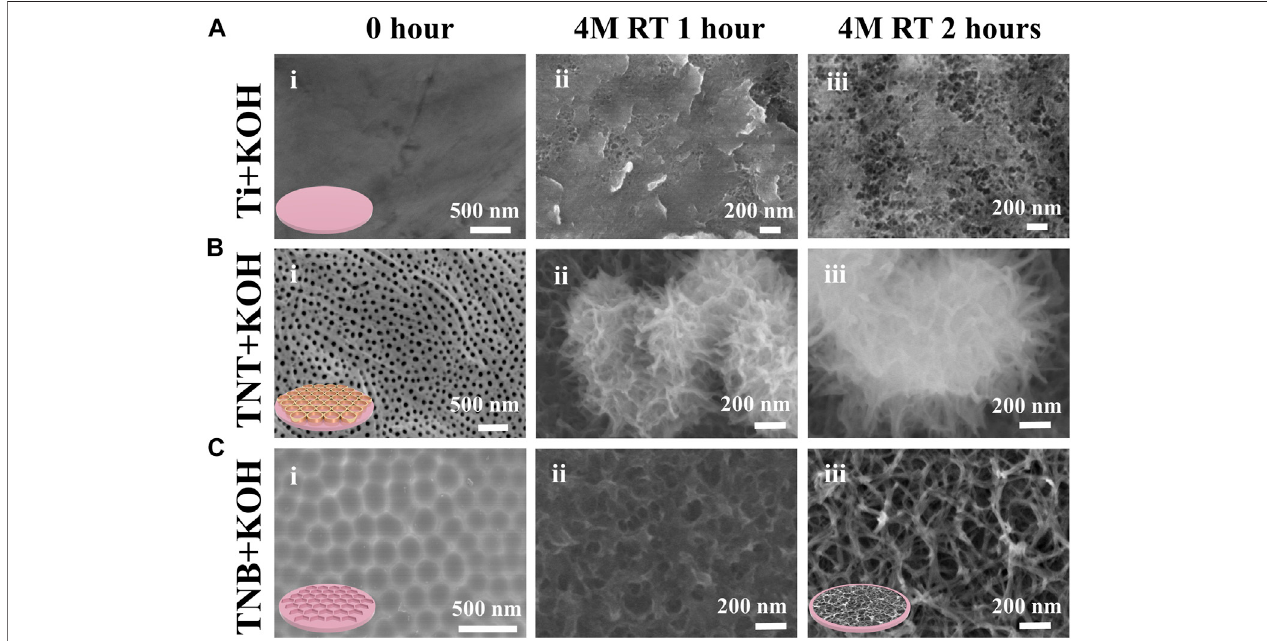
FIGURE 2 | FE-SEM images of (A) Ti, (B) TNT, and (C) TNB were soaked in 4M KOH alkaline aqueous solution under normal temperature and pressure for 0, 1, and 2 h.